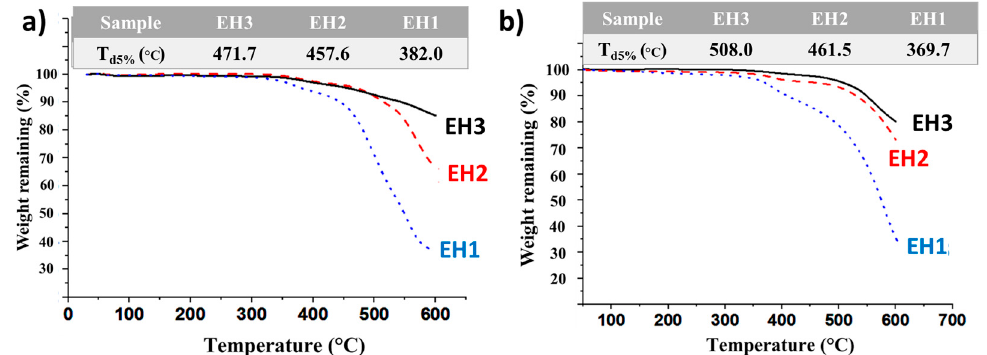
Figure 3. TGA curves of getter elastomer EH x ( x = 1, 2, 3) in N 2 ( a ) and in air ( b ). Stress-strain testing of the samples demonstrated a maximum tensile strength of about 0.4 MPa and a break elongation of about 120% (Table S1). Reactivity of the cured getters was also evaluated by testing in pure and dilute hydrogen atmospheres. Com- pared with the results for the PH x samples, the capacities of all EH x samples were reduced (Figure 4).